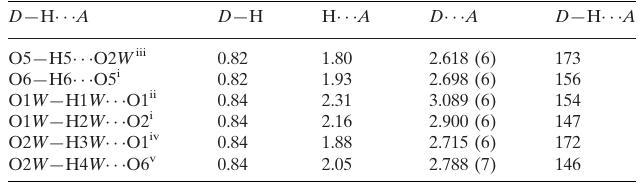
Hydrogen-bond geometry (A˚ , (cid:3)